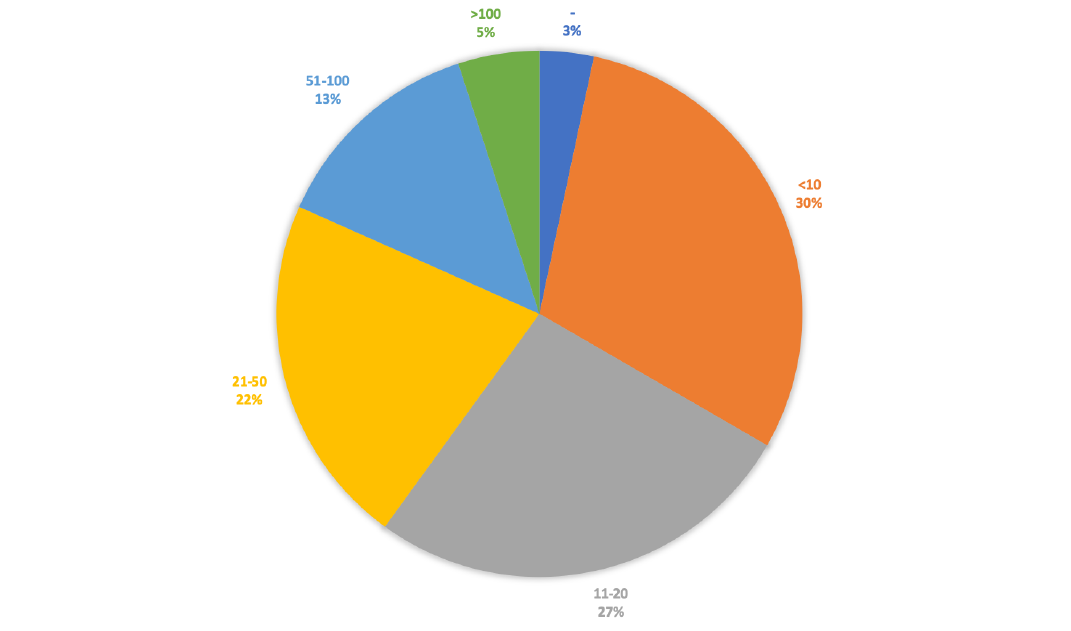
Figure 6. Distribution of the number of participants per included study. - denotes studies which did not provide information on number of